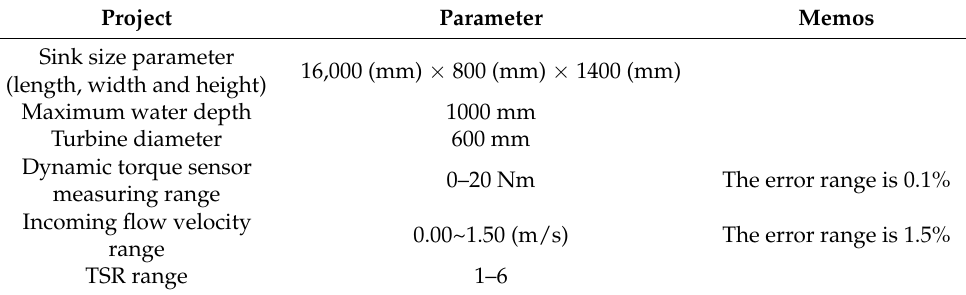
Figure 7. ( a ) Water channel ( b ) Experimental prototype.